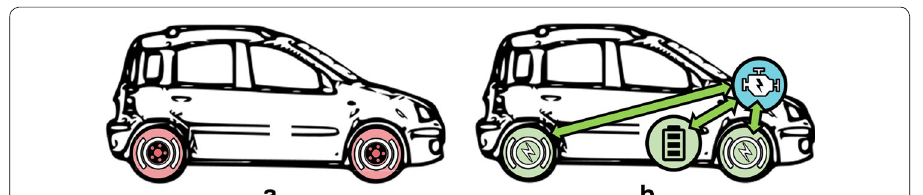
Fig. 1 Brakes in electric vehicles: a friction and b regenerative